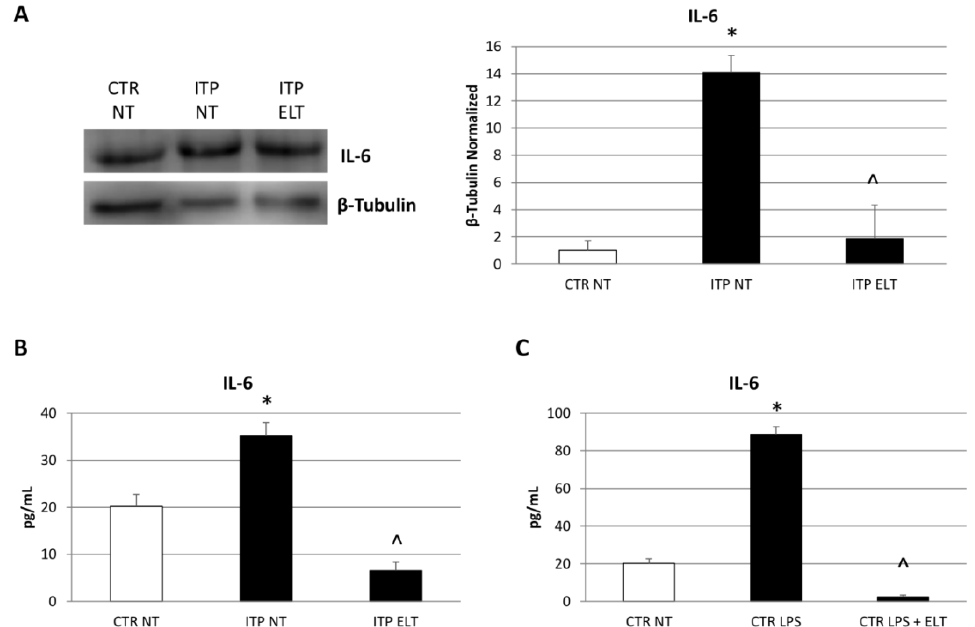
Figure 2. Effect of ELT on Interleukin-6 (IL-6) protein expression and release. ( A ) IL-6 protein expression levels in ITP macrophages compared with CTR macrophages, determined by Western Blot, starting from 20 µ g of total lysates after treatment with ELT (6 µ M). The most representative images are displayed. The proteins were detected using Image Studio Digits software, and the intensity of immunoblots compared to the untreated control, taken as 1 (arbitrary unit), were quantified after normalizing with respective loading controls for the housekeeping protein β -Tubulin. Histogram shows IL-6 expression levels as the mean ± S.D. of independent experiments on each individual sample. A t -test was used for statistical analysis. * indicates p ≤ 0.05 compared to CTR NT, ˆ indicates p ≤ 0.05 compared ITP NT. ( B ) IL-6 concentrations (pg/mL) in ITP macrophages compared with CTR macrophages, determined by enzyme-linked immunosorbent assay (ELISA), after treatment with ELT (6 µ M). Histogram shows IL-6 concentration as the mean ± S.D of independent experiments on each individual sample. The cytokines concentration was determined on a standard concentration curve according to the manufacturer’s instructions. A t -test wasused for statistical analysis. * indicates p ≤ 0.05 compared to CTR NT, ˆ indicates p ≤ 0.05 compared ITP NT. ( C ) IL-6 concentrations (pg/mL) in ITP macrophages compared with CTR macrophages, determined by ELISA Assay, after treatment with lipopolysaccharide (LPS) (500 nM) and LPS combined with ELT (6 µ M). Histogram shows IL-6 concentration as the mean ± S.D. of independent experiments on each individual sample. The cytokines concentration was determined on a standard concentration curve according to the manufacturer’s instructions. A t -test was used for statistical analysis. * indicates p ≤ 0.05 compared to CTR NT, ˆ indicates p ≤ 0.05 compared to CTR LPS.